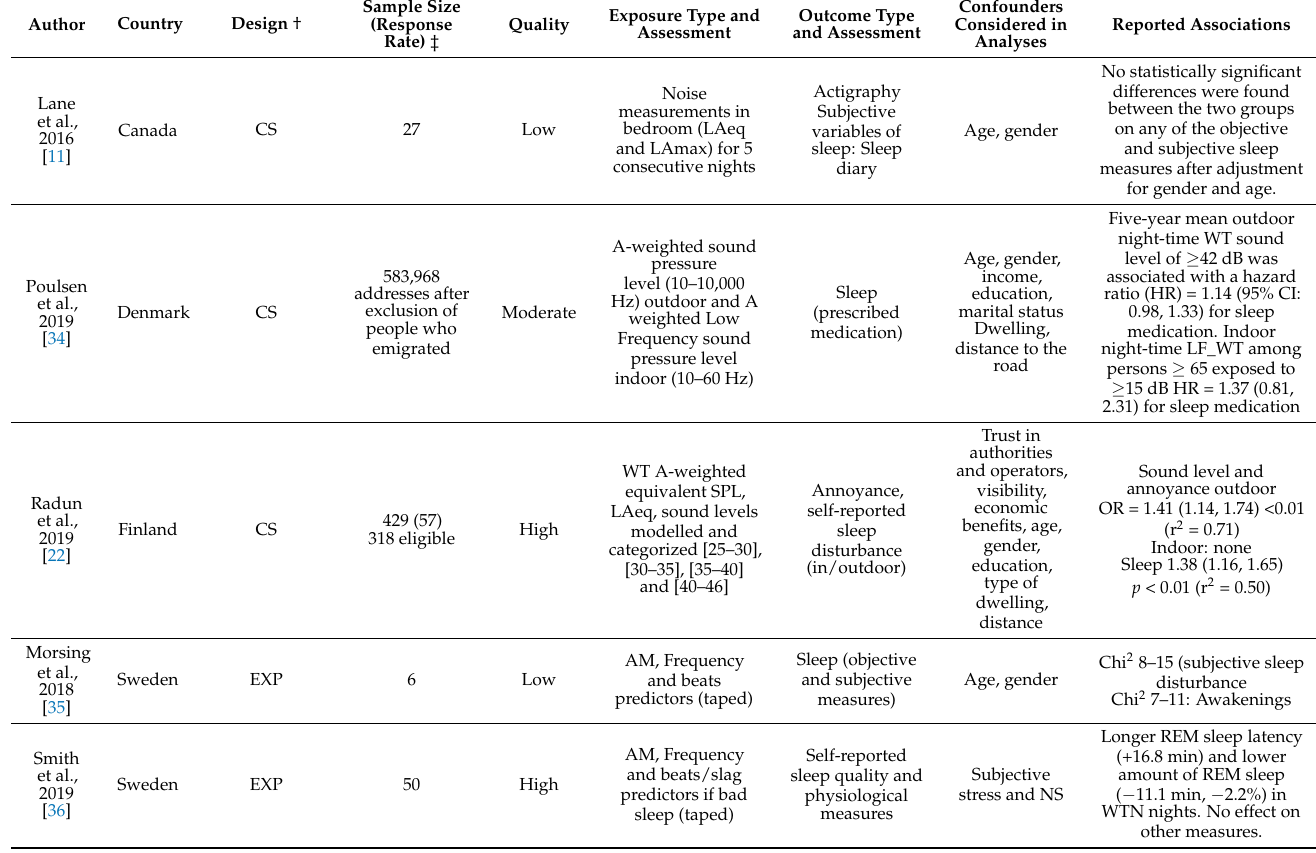
Table 3. Overview of the characteristics of the selected studies on WT sound and sleep (self-reported, physiologi-